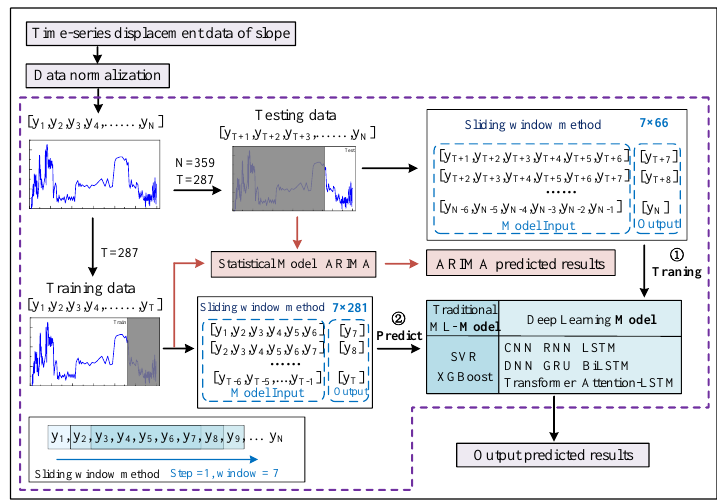
Figure 4. Workflow of slope deformation